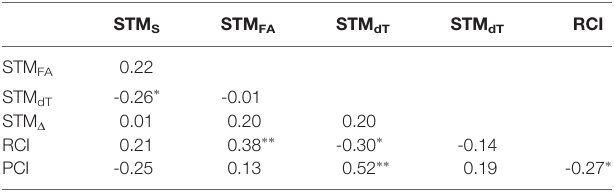
TABLE 2 | Pearson correlation coef fi cients matrix among short-term memory (STM) traits and drought tolerant indices.